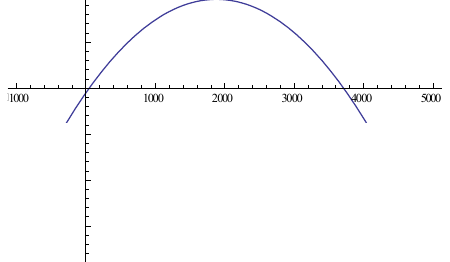
Fig. 2. Graphical representation of ),|( **